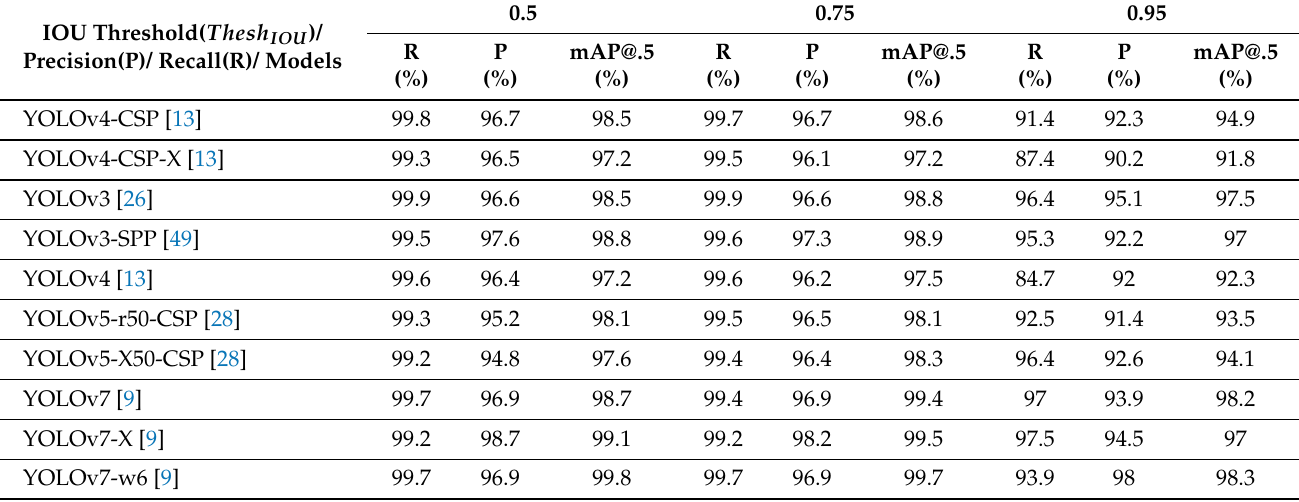
Table 2. The results of hand detection and classification on the FPHAB dataset when performed on YOLOv7 and YOLO-family